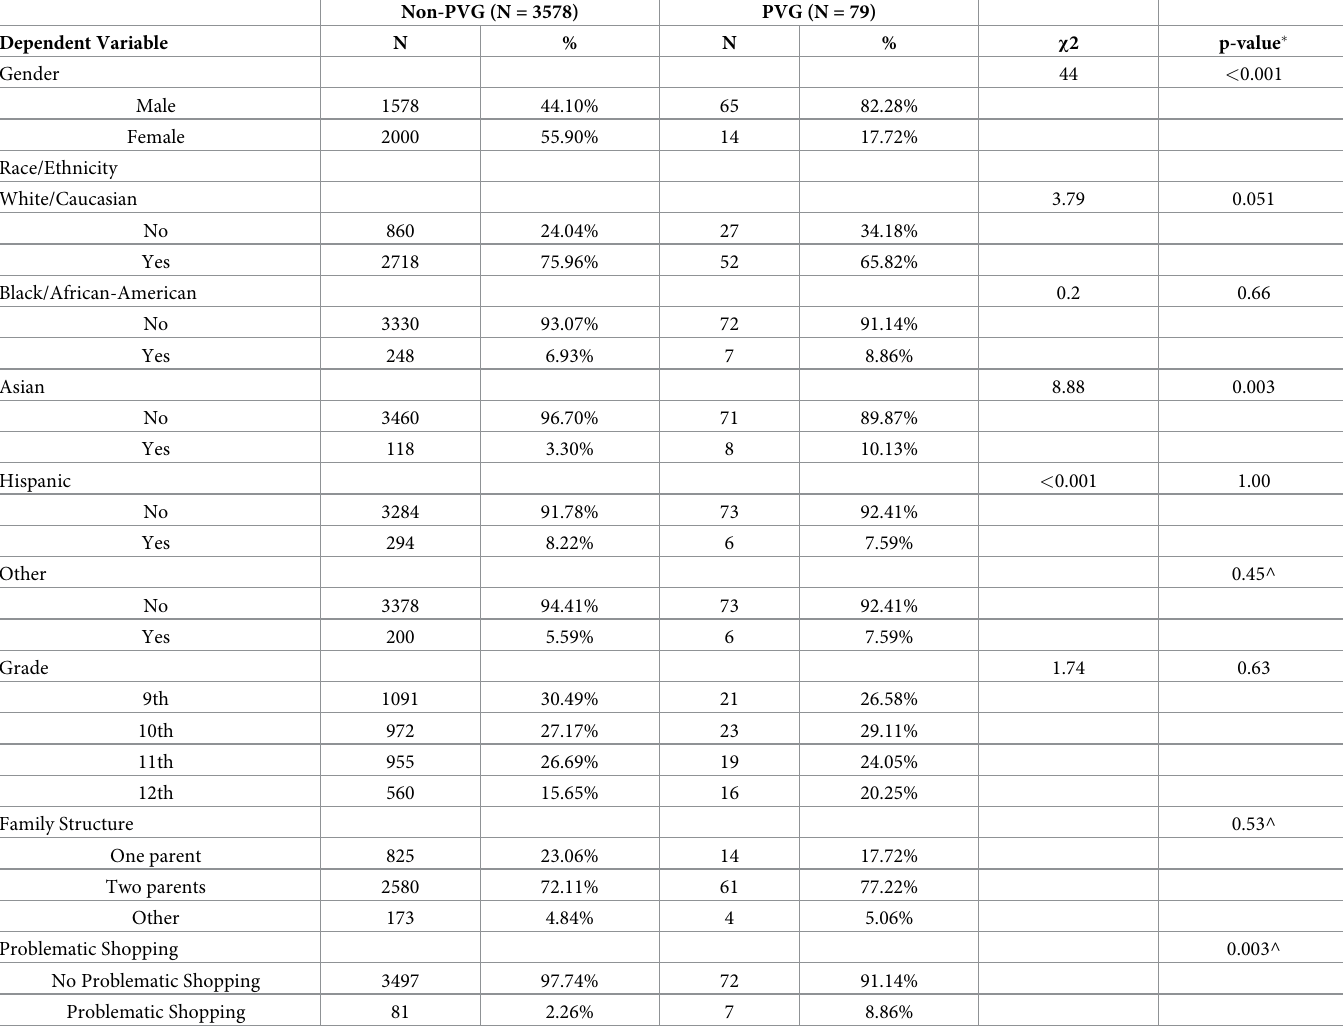
Table 2. Sociodemographic characteristics of adolescents with and without problematic video